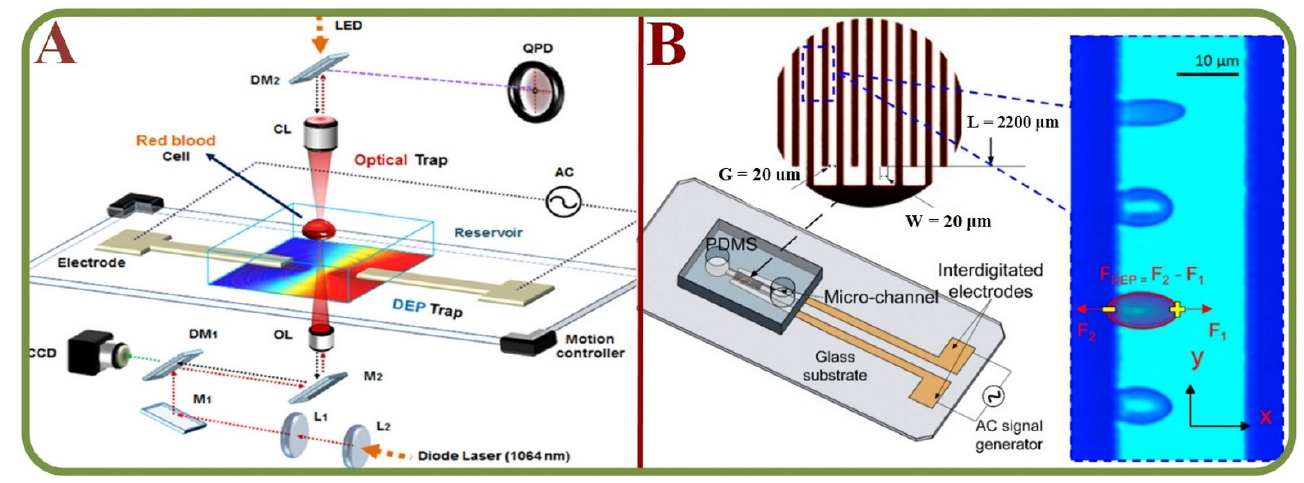
Figure 9. RBC Dielectrophoretic Analysis. ( A ) The system schematics of dielectrophoretic force measurement of RBCs exposed to oxidative stress using optical tweezers [140]. ( B ) The dielectrophoresis testing of nonlinear viscoelastic behaviors of human RBCs, including the biomechanics testing schematics of live cells using the dielectrophoresis effects [143].